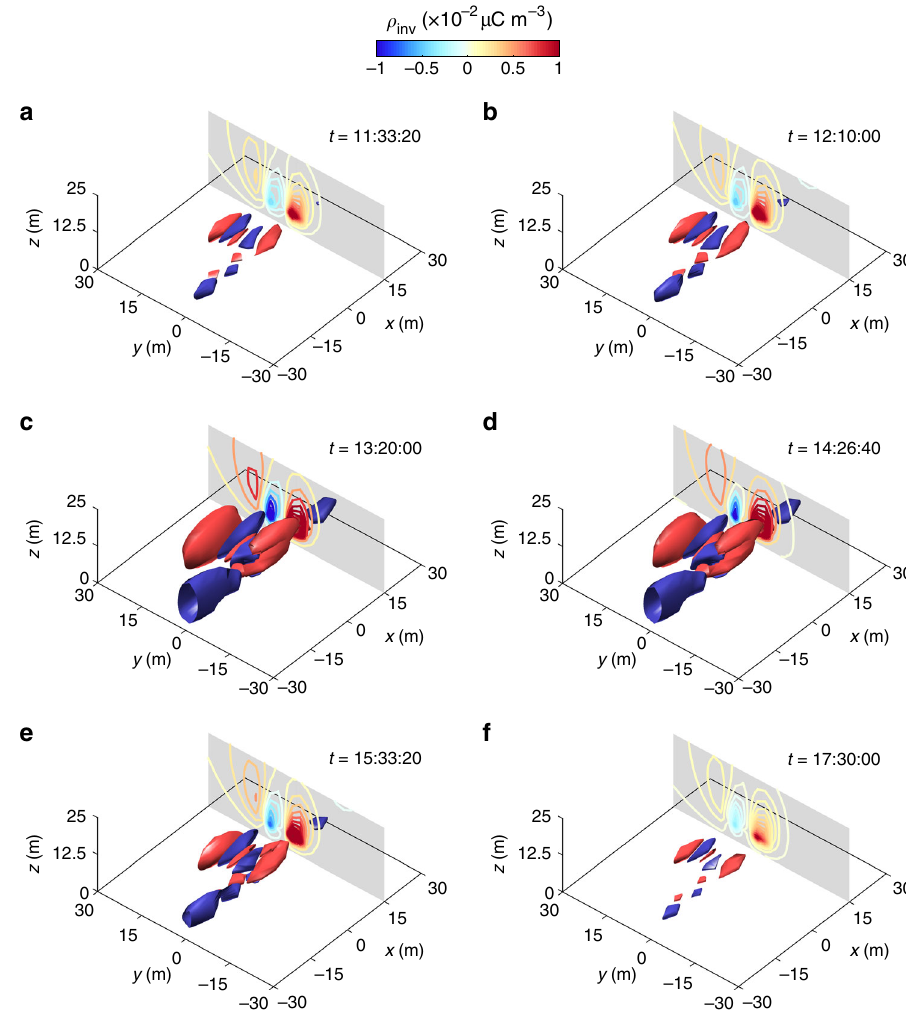
Fig. 5 Evolution of the 3D structure of the space-charge densities during storm #1. a – f The reconstructed space-charge densities ρ inv at different stages of the observed dust storm. The isosurfaces are shown at a space-charge density magnitude of 2 × 10 − 2 μ C m − 3 ; the positive surfaces are colored in red, while the negative surfaces are colored in blue. Times t are shown as the local time on April 16, 2017 (UTC + 8). Contourslices at x = 15 m are colored based on the space-charge